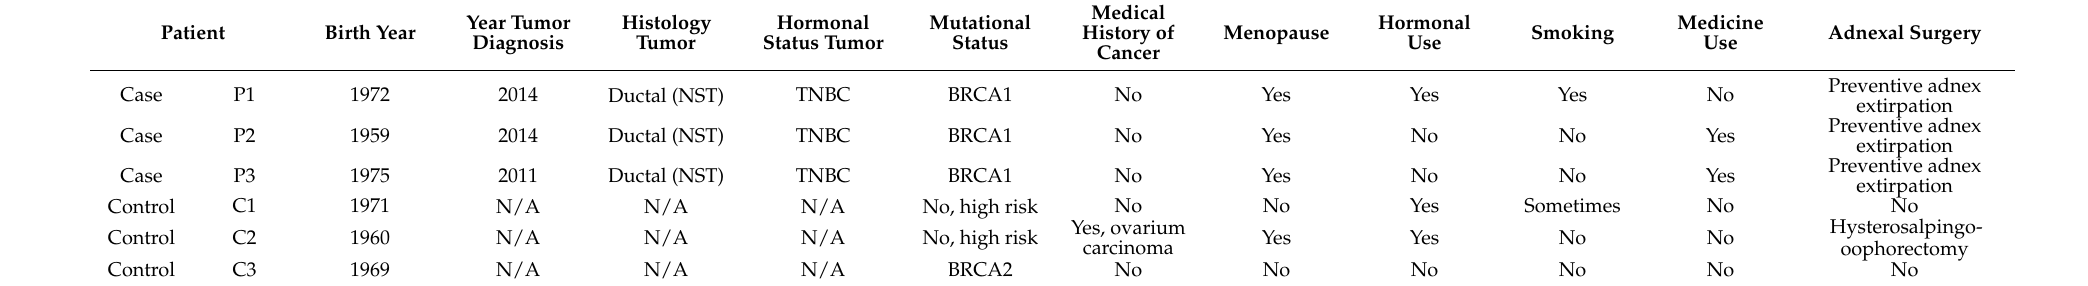
Table 1. Patient